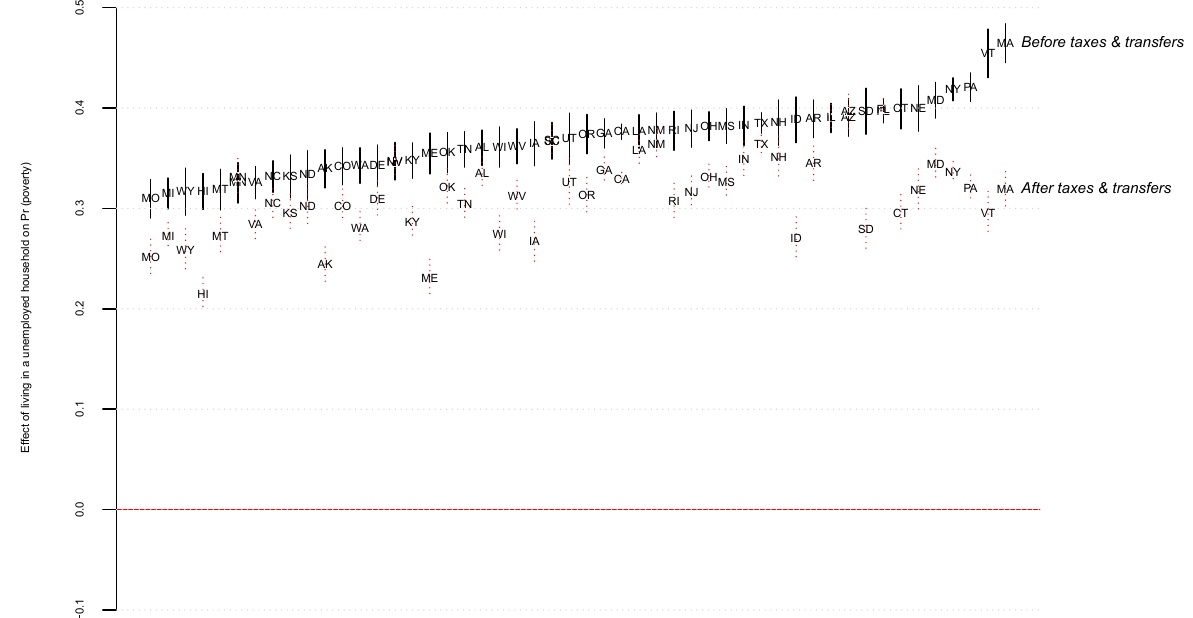
Figure 4: Unemployment penalty: effects of living in an unemployed household on Pr (poverty) before and after taxes and transfers (2012–2016 CPS). Adjustments for SNAP, SSI, and TANF underreporting were made using the Urban Institute Transfer Income Model (TRIM). Effects represent coefficients from varying slope linear probability models predicting SPM poverty. The nonvarying slopes in the model are year fixed effects and a control for metropolitan and/or nonmetropolitan status. States are indicated by their postal code